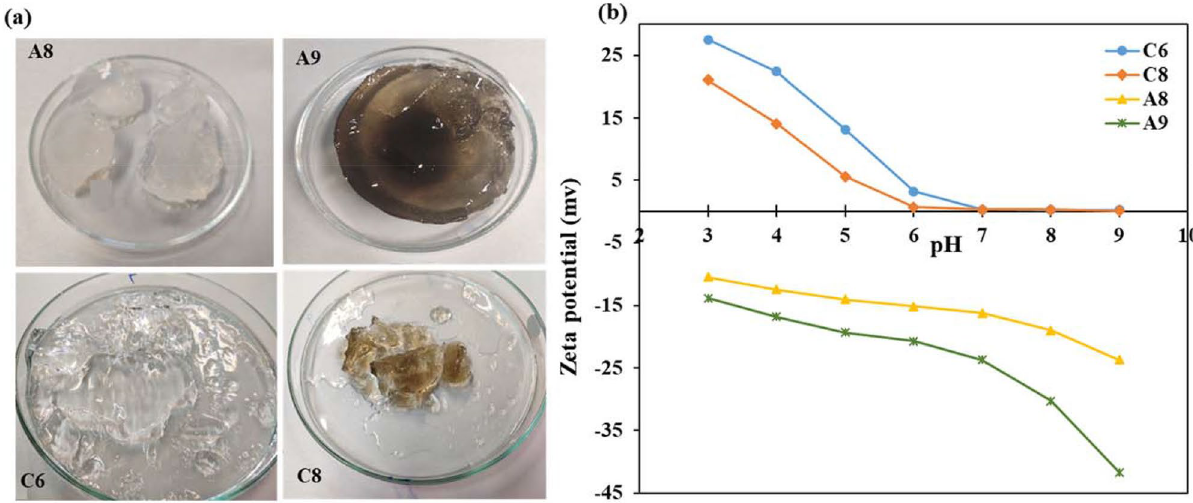
Figure 5. ( a ) Photos of the selected SA-based (A8, A9), and CH-based (C6, C8) hydrogel samples swelled in deionized water before drying process. ( b ) Zeta potential analysis of selected SA-based (A8, A9), and CH-based (C6, C8)